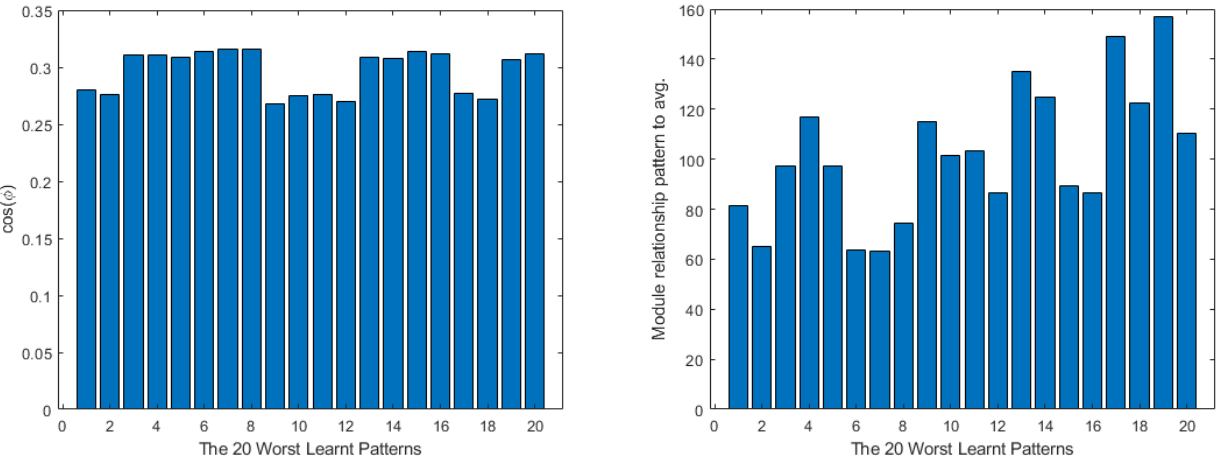
(cid:12) (cid:12) 𝜕𝐿𝑜𝑠𝑠 ∂ Loss (cid:12) (cid:12) | relationship to the average (cid:12) (cid:12) relationship to the average ∂ W n 𝜕𝑊 𝑛